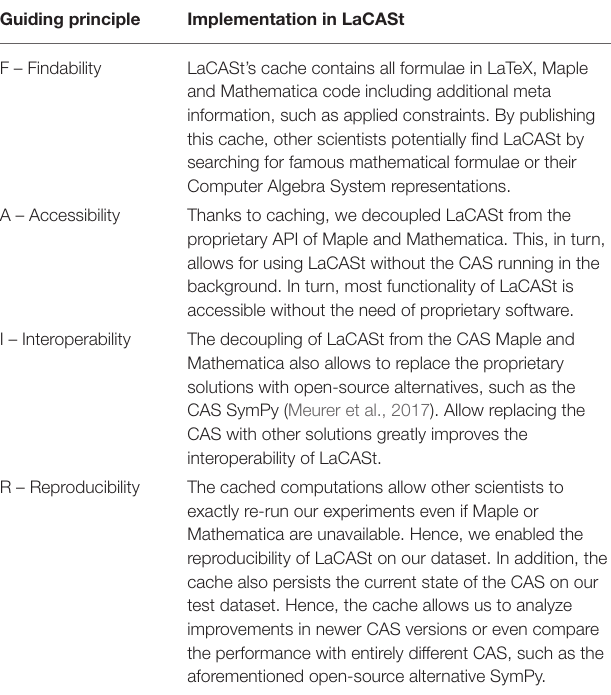
TABLE 1 | LaCASt’s implemented characteristics that influences FAIR